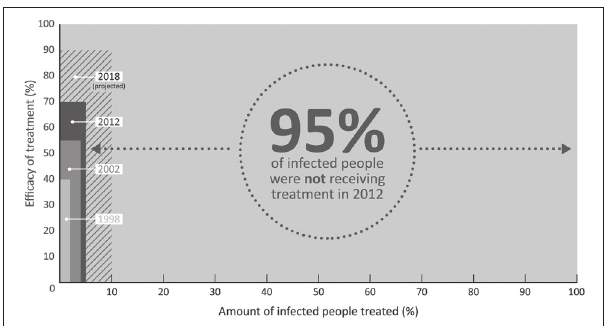
Figure 1) The disparity between potential hepatitis C virus (HCV) treat- ment efficacy and projected HCV treatment effectiveness. High efficacy of HCV treatment is projected over five to 10 years. Sustained virological response (SVR) has increased from 40% with interferon (IFN) and riba- virin (RBV) in 1998, 55% with pegylated-IFN (PEG-IFN) and RBV in 2002, approximately 70% in the era of PEG-IFN, RBV, and a protease inhibitor in 2012 (genotype 1 only; patients with HCV genotype 2 or 3 will still have an SVR of approximately 80% with PEG-IFN-RBV) and IFN- free regimens are anticipated to be available by 2018, with an expected SVR of 90%. However, the global effects of new treatments are negligible without expanded access given the low treatment uptake among individuals with HCV infection (57-59). Reproduced with permission from reference